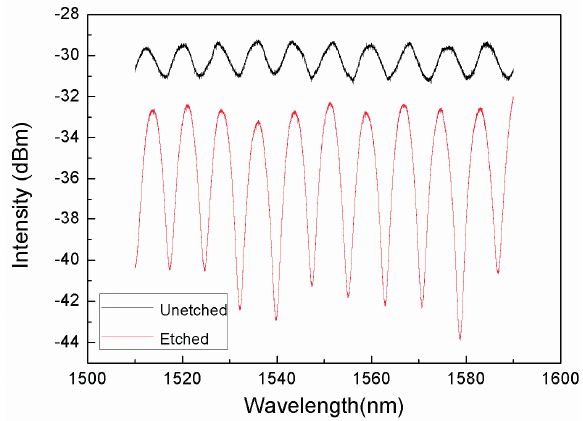
Figure 5. Interference patterns of IFPIs, based on unetched SMF-PCF (black line) and suspended microfiber (red line).